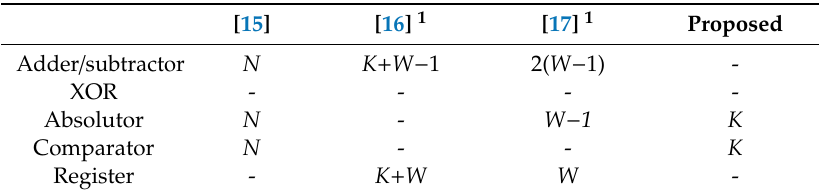
Table 1. Summary of hardware